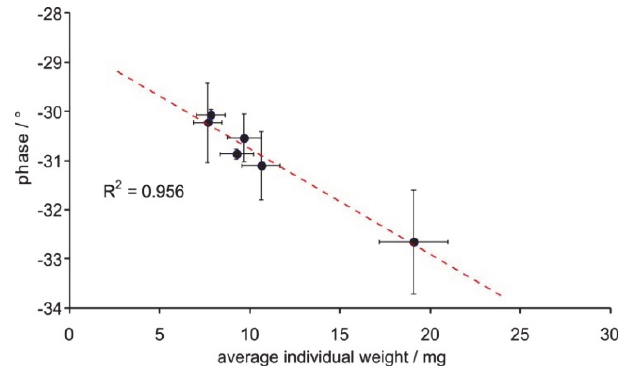
Fig. 6: Phase response per mg of worm for 6 groups of differently sized groups of worms from different diets at 440 Hz. Diets from left to right: TetraMin ® / starch mix COD/N=37; TetraMin ® / starch mix COD/N=56; TetraMin ® pure; Okara; soy meal; chlorella. Error bars are due to worm weight variation (abscissa) and measurement error (ordinate),